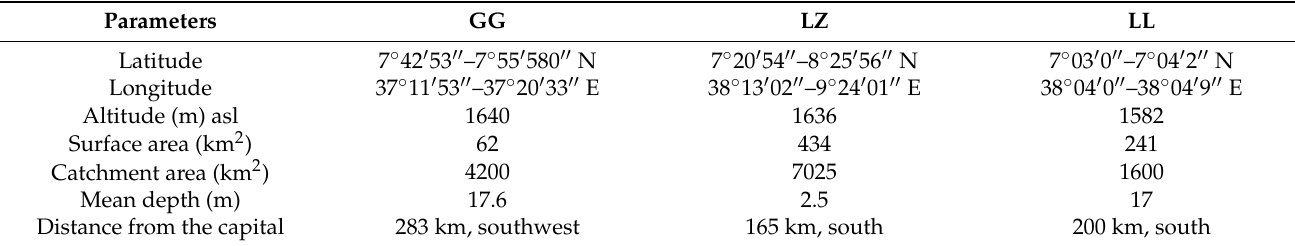
Table 1. Geographic description of the three Ethiopian lakes in this